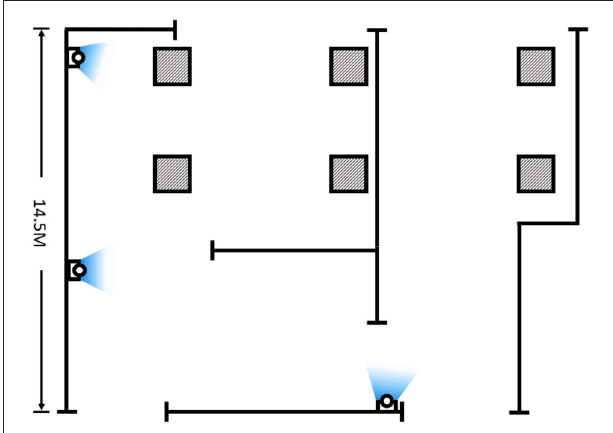
FIGURE 10 | The diagrammatic sketch of experiment construction site and camera sets.